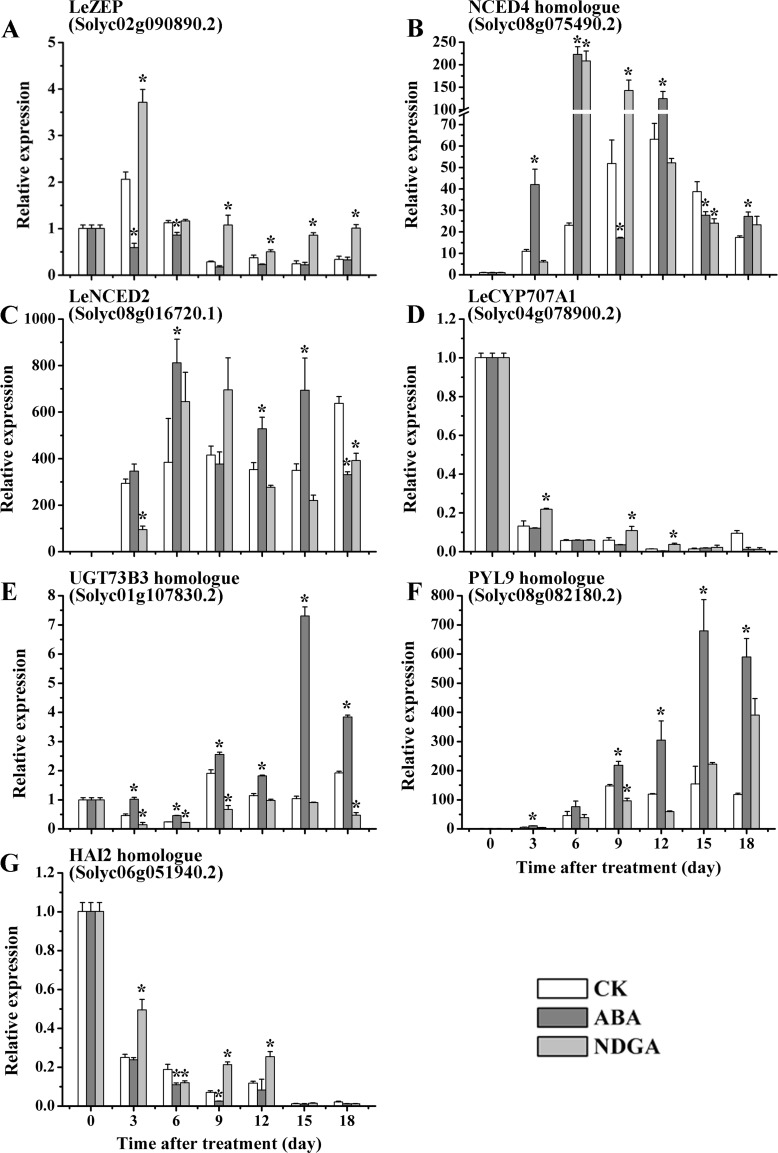
The expression of DEGs related to ABA metabolism and signaling in CK, ABA and NDGA-treated fruits at different ripening stages.RT-PCR analysis of ZEP (A), NCED4 (B), NCED5 (C), ABA80X (D), UGT73B3 (E), PYL9 (F) and HAI2 (G) were conducted in CK vs ABA and CK vs NDGA treatment. Numbers under the x-axis represents the different time points during fruit ripening while y-axis shows relative expression in folds between CK and ABA/NDGA-treated fruits. Error bars represents SE of three biological replicates, and asterisks (*) indicates significant difference (P < 0.05) between the value in ABA or NDGA treated-fruits and that in control (CK).